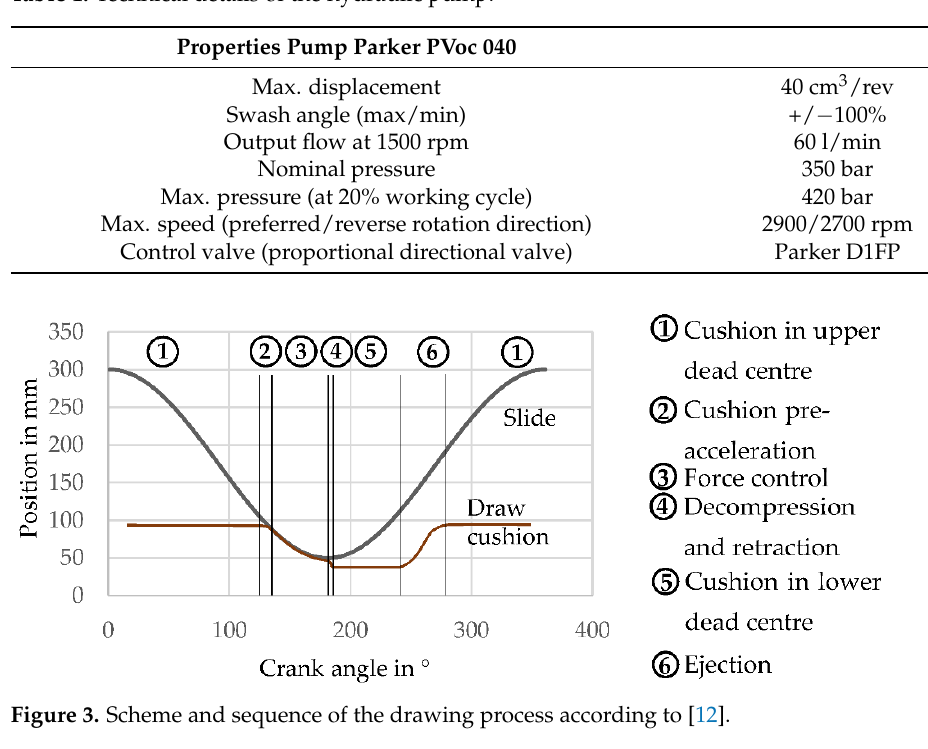
Table 1. Technical details of the hydraulic pump.